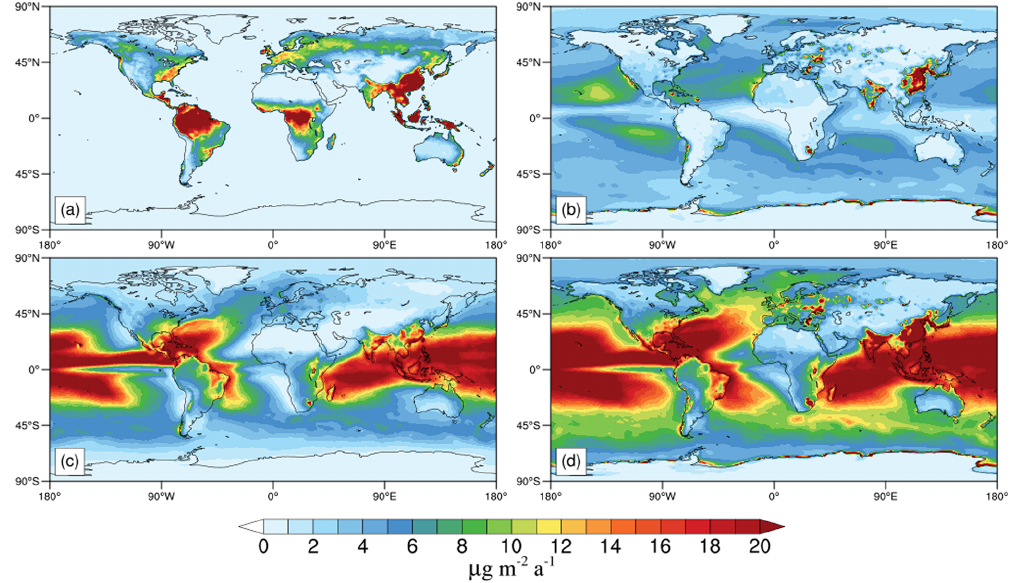
Figure 6. Global distribution of annual mean Hg deposition fluxes during 2011–2013 in CAM6-Chem/Hg: (a) Hg 0 dry deposition, (b) Hg II dry deposition (including sea-salt uptake), (c) Hg II wet deposition, and (d) Hg II total deposition.